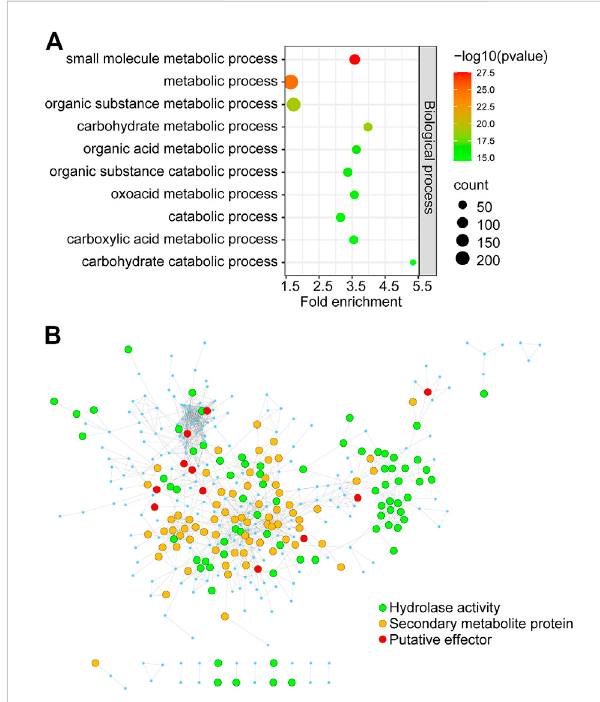
FIGURE 7 The PPI regulatory network of proteins encoded by in planta Fusarium graminearum DEGs (A) GO terms signi fi cantly associated with DEGs in the PPI regulatory network. (B) The Fusarium graminearum DEG regulatory network consists of 366 proteins. Each node represents a protein. Each line represents an interaction. Functions are color-coded. Green represents proteins involved in hydrolase activity, orange represents secondary metabolite proteins, and red represents putative effectors from this and previous